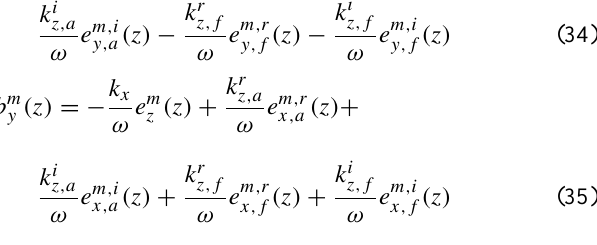
The magnetic field components in each region may be